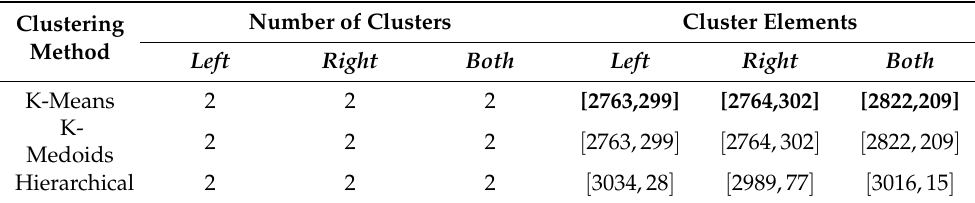
Table 5. Clusters adopted in our study for each case. The best results are indicated with bold.